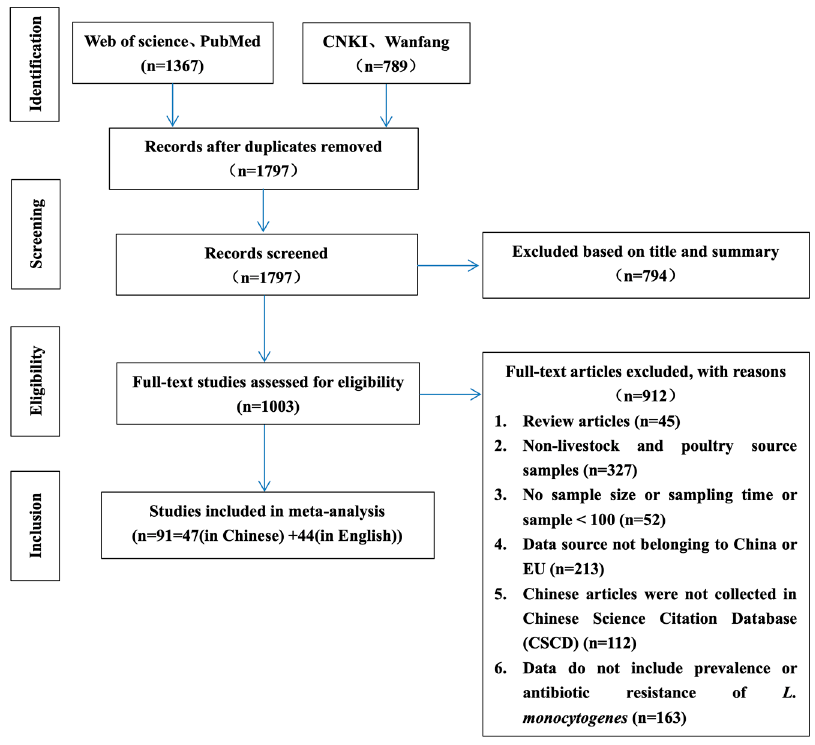
Figure 1. Flow diagram of the literature search and selection of eligible studies.